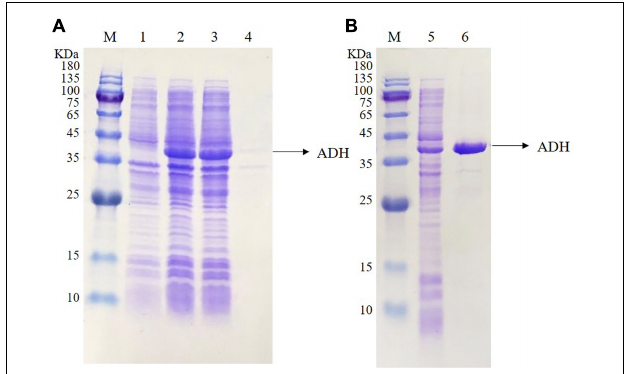
FIGURE 3 | Sodium Dodecyl Sulfate PolyAcrylamide Gel Electrophoresis (SDS-PAGE) analysis of the expressed ADH (A) and the purified ADH (B) . Lane M, protein marker; lane 1, the total proteins of E. coli BL21 star (DE3)-pET22b; lane 2, the total proteins of E. coli BL21 star (DE3)-pET22b- adh ; lane 3, the soluble supernatant of E. coli BL21 star (DE3)-pET22b- adh ; lane 4, the inclusion body of E. coli BL21 star (DE3)-pET22b- adh ; lane 5, ADH crude enzyme solution; lane 6, ADH purified enzyme solution.